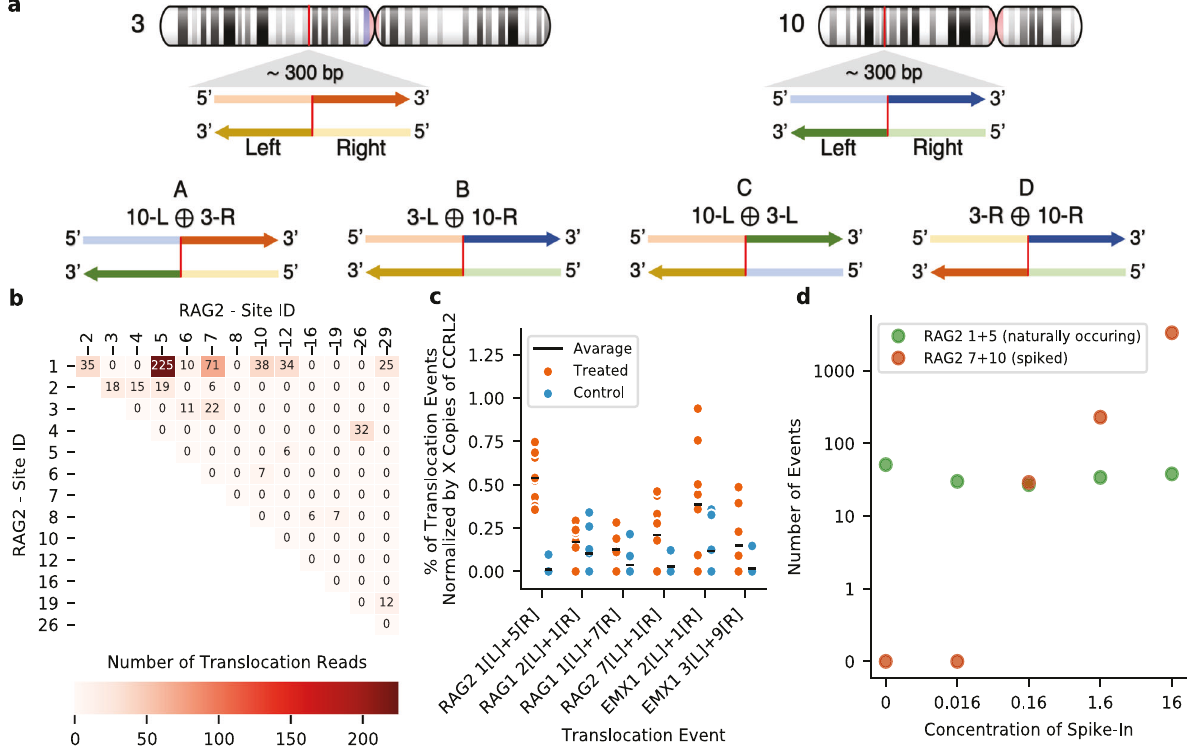
Fig. 3 CRISPECTOR detects and quanti fi es adverse translocation events. a Schematic description of all four translocation types. Schematic description of all possible translocations for chromosomes 3 and 10 p arms. The expected cut-sites are colored red and ⊕ denotes the concatenation/fusion of the sequences. The four possible fusion types give rise to structures that are either single-centromeric (A & B), centromere-free (C), or double-centromeric (D). b Translocation reads heatmap for RAG2 , XT 2p, HEK293-Cas9. 19 translocations with a Hypergeometric (FDR corrected) p -value < 0.05 are presented in the heatmap with the associated read counts. For example: 225 reads were found between RAG2_5 and RAG2_1 , yielding a p -value of 1.53 × 10 − 65 . c ddPCR Validation of translocation events. Speci fi c translocation or structural variation events were individually experimentally measured using event-speci fi c ddPCR primers and probes. The means of 8 technical repeats are also depicted above (black lines). WRS (Wilcoxon Rank Sum) 41 one-sided p -values to support the higher Tx values measured are: 7.7 × 10 − 4 , 0.29, 0.027, 0.074, 0.09, and 0.17, ordered as in the fi gure. Source data is provided as a source data fi le. d Validation of CRISPECTOR translocation detection process based on synthetic spike-in standards. Edited RAG2 , XT 2p, HEK293-Cas9 genomic DNA was spiked-in with serial dilutions (0, 0.016, 0.16, 1.6 and 16%) of RAG2_10/RAG2_7 synthetic fusion construct (see text). Observed numbers of fusion reads for the spiked-in RAG2_10/RAG2_7 construct (in orange) and for the naturally occurring RAG2_1/RAG2_5 (in green) are